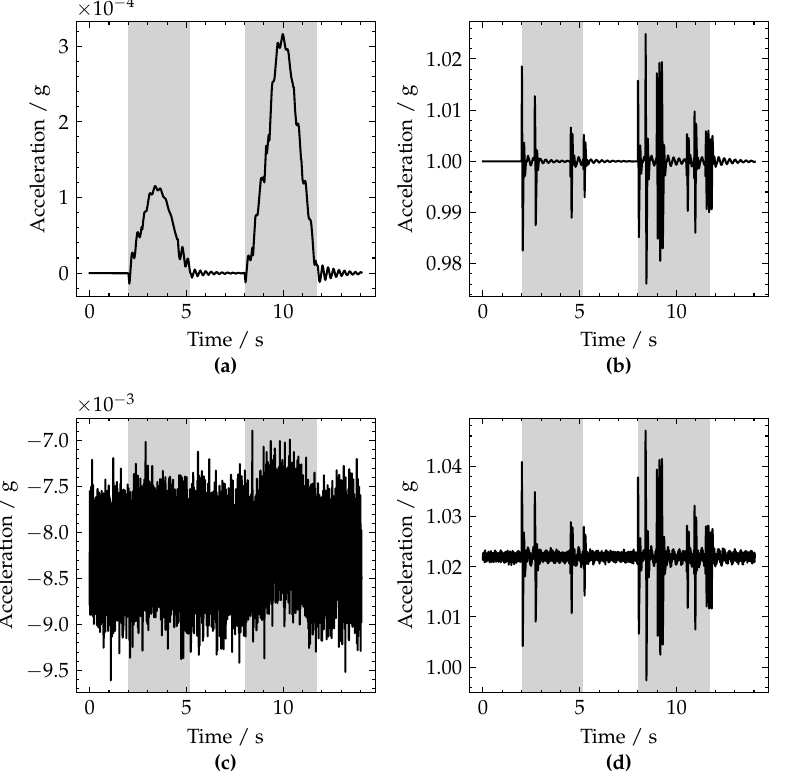
Figure 6. Plots of ideal accelerometer signals for ( a ) x-axis and ( b ) y-axis; simulated accelerometer signals with additive noise for ( c ) x-axis and ( d ) y-axis. Periods when a vehicle is crossing the bridge are shaded